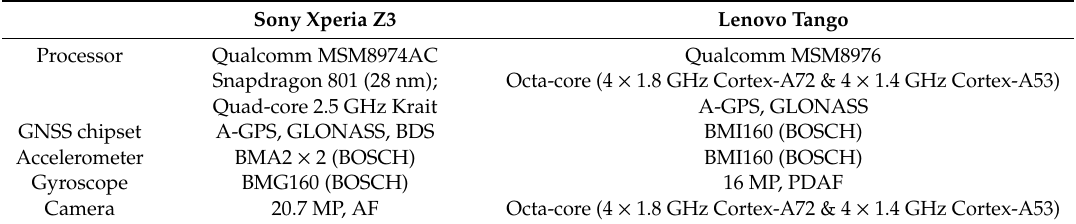
Table 1. Technical characteristics of tested